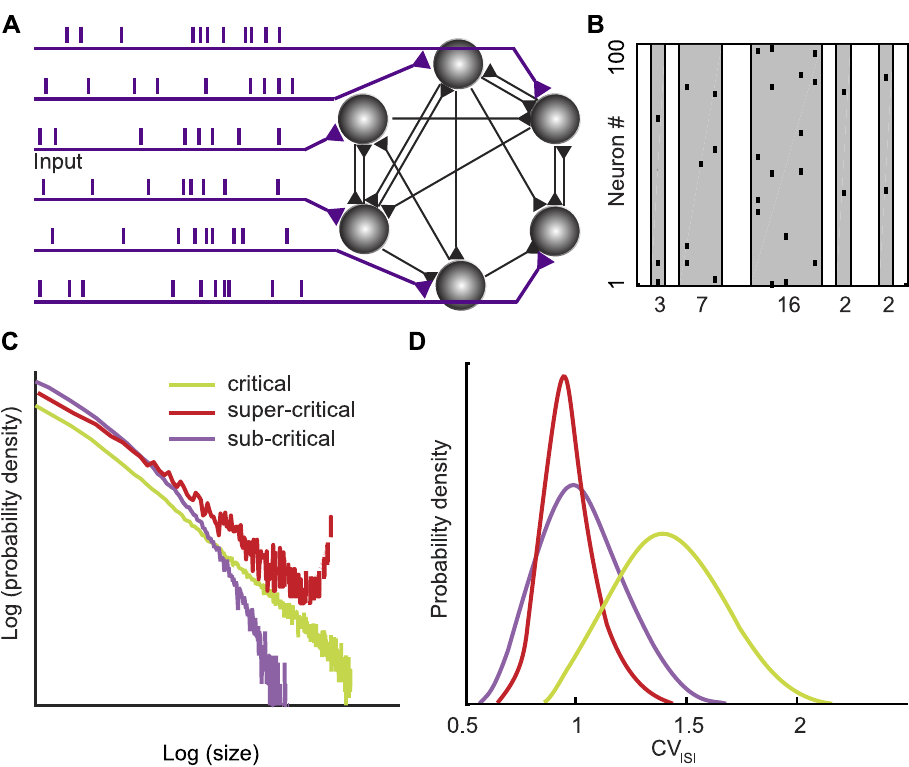
Fig 1. A quantification of the level of spike correlation in recurrentcortical circuits and its variation with external inputs is essential for understanding cortical computation. (A) Schematicof a recurrent neuralcircuit consistingof neurons(gray), connections (black), and externalinputs (purple).(B) Neuronal avalanches (gray) are contiguous bouts of spikes (black raster) across the recordedneurons.The spike count within an avalanchedeterminesthe avalanchesize (numbers). (C) The shape of the avalanchesize distribution reflects the level of spatiotemporal correlationwithin the network. A power law avalanchesize distribution (straight line in the log log plot) is a characteristic feature of the critical (green) network state. Deviationsfrom the power law distributions indicatethe subcritical(purple) and supercritical(red) network state. (D) Theory predicts that operatingnear the critical network state impacts the variabilityof neuronal spikingas characterized by the coefficient of variation (CV ISI ) of the interspike interval (ISI). Specifically, irregularspiking (CV ISI > 1) has been predictedto emergeat the critical network (green), whereasfor the subcritical(purple)and the supercritical (red) network state the CV ISI distributionpeaks near